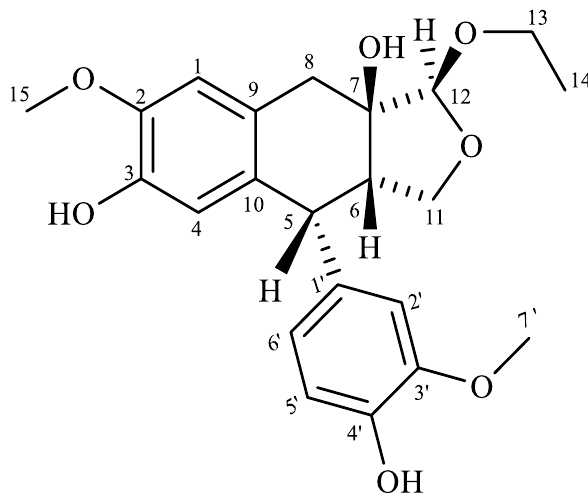
Figure 1. Chemical structure of ferruginan isolated from O. ferruginea.